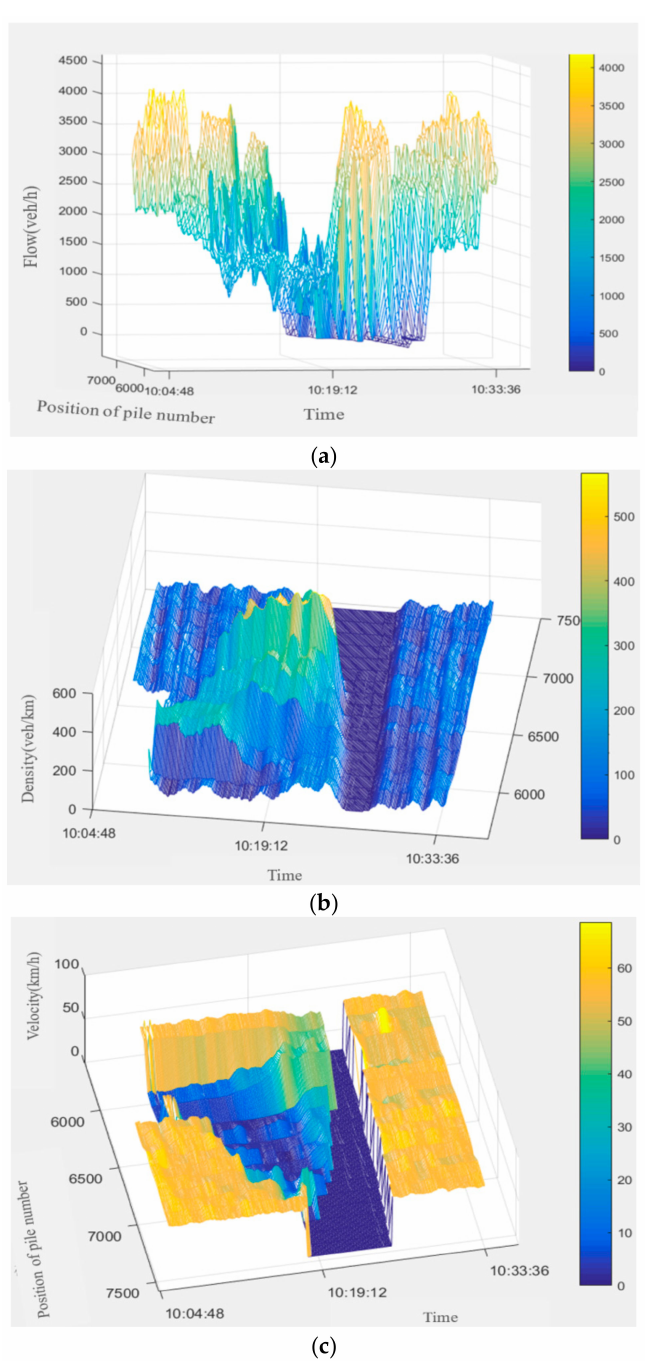
Figure 1. Spatial and temporal distribution of flow, density, and velocity in the whole accident process. ( a ) Spatial and temporal distribution of flow, ( b ) Spatial and temporal distribution of density, ( c ) Spatial and temporal distribution of